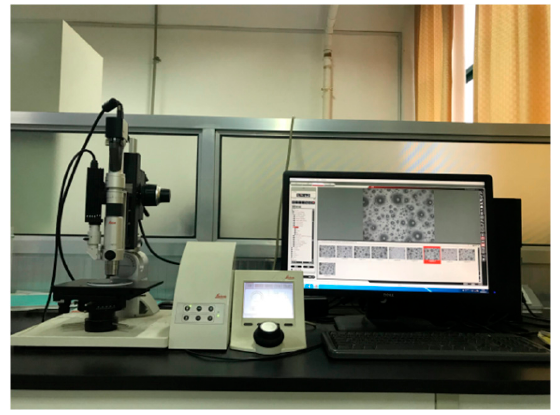
Figure 5. CCD image acquisition system.